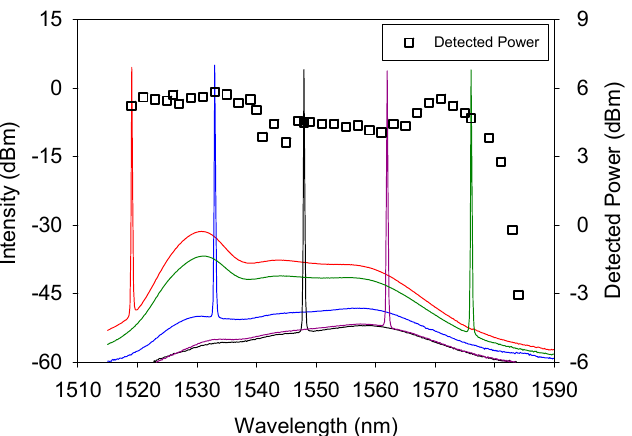
Figure 4. Measured output spectrum of proposed fiber laser and corresponding output power in a tuning range of 1519.0 to 1584.0 nm.